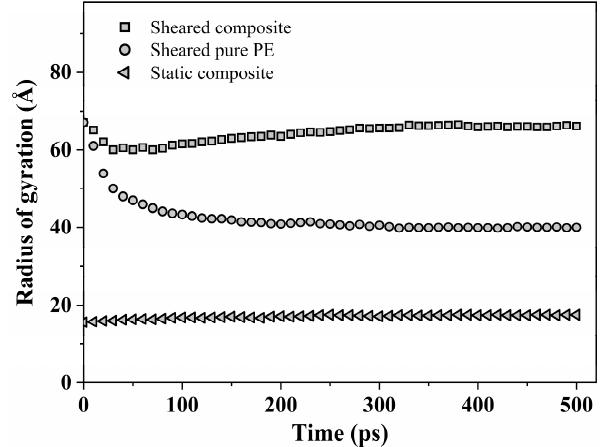
Figure 3. The evolution curve of the mean radius of gyration of PE molecular chains.